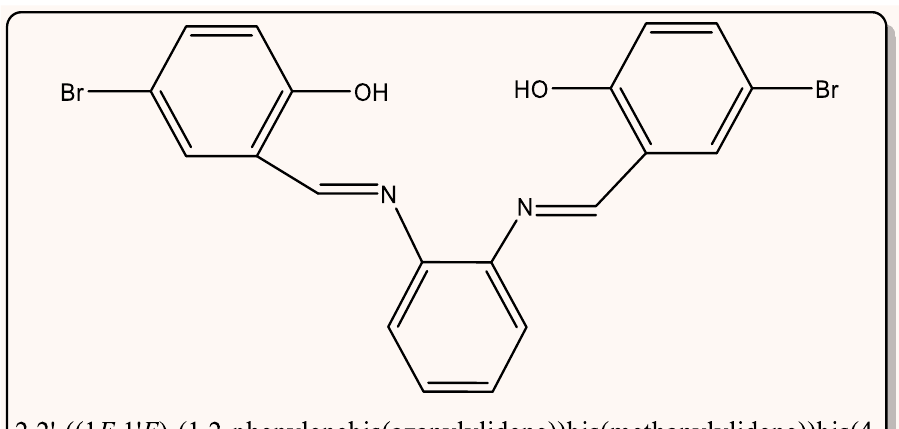
Figure 1. Schematic route for preparation of free ligand.